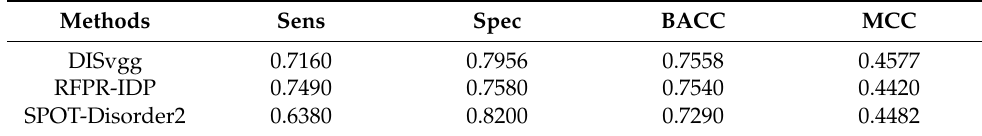
Table 3. Performance Parameters on Blind Test Dataset